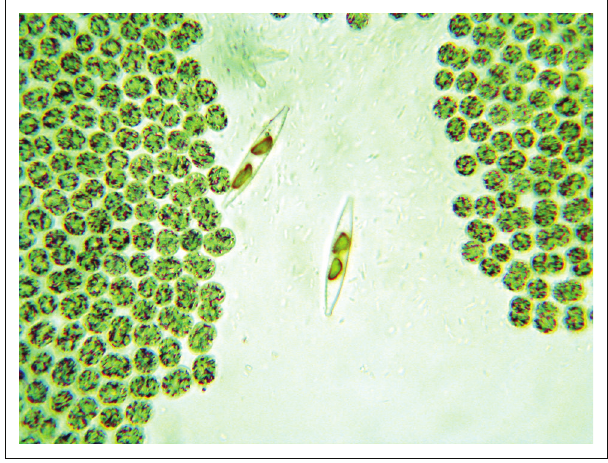
Source : Microscopic photo taken by E.H. Dekker X400 magnification. FIGURE 7: Microscopic image showing sheets of Microcystis spp. organisms plus two diatoms.